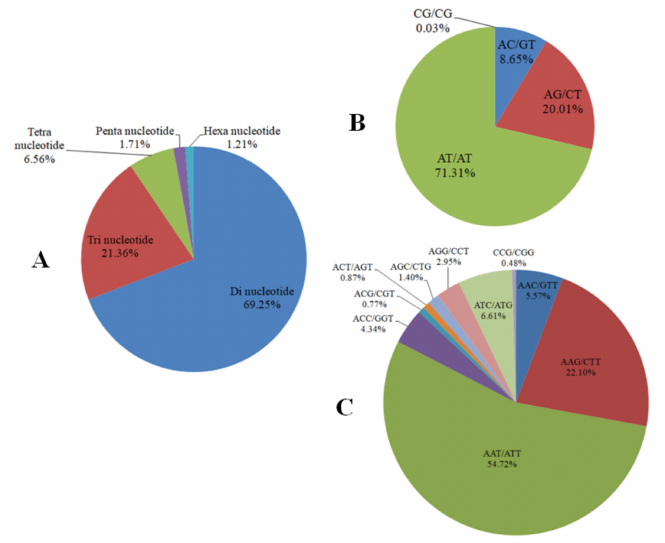
Figure 3. Characteristics of SSR markers. ( A ) Frequency of different SSR markers; ( B ) Frequency of different Di-nucleotide SSR markers; ( C ) Frequency of different Tri-nucleotide SSR markers.